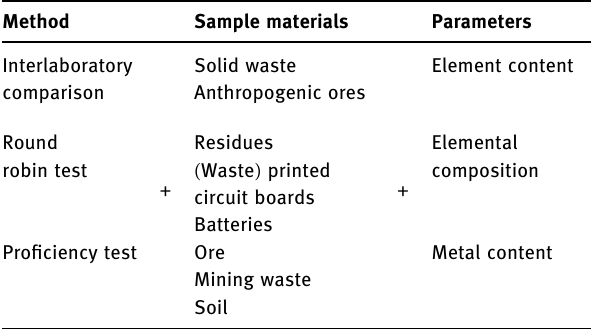
Table 1: Keywords for the literature research on RRT for CA of spe - ci fi ed sample matrices. The left column denotes the ( synonymous ) terms for RRT, the middle column denotes the sample material, and the right column denotes the analysis